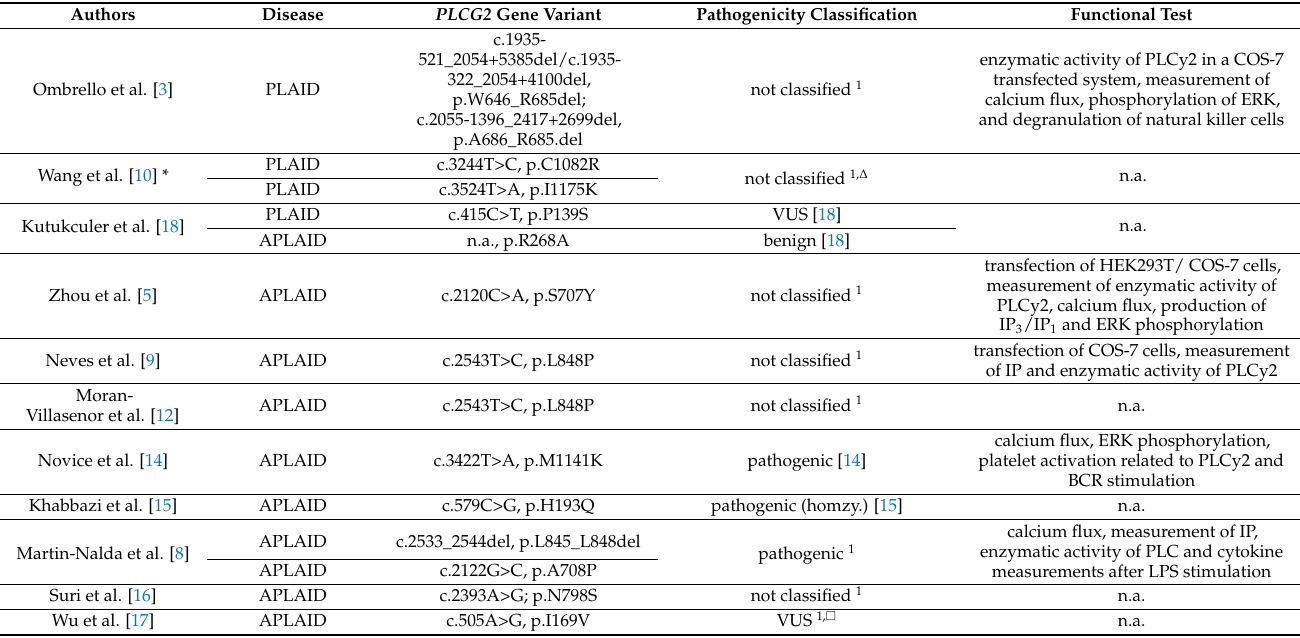
Table 3. Genetic and functional characteristics of previously described PLCG2 gene variants causing PLAID and APLAID phenotype.